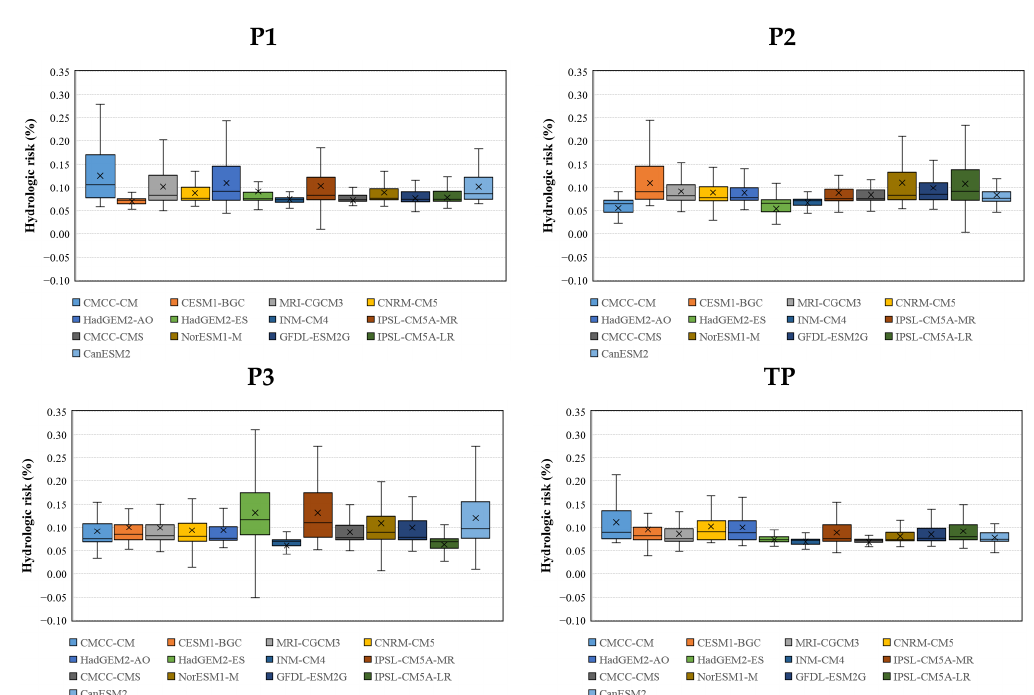
Figure 6. Box plots of hydrologic risks of the 100-year flood according to the RCP 4.5.